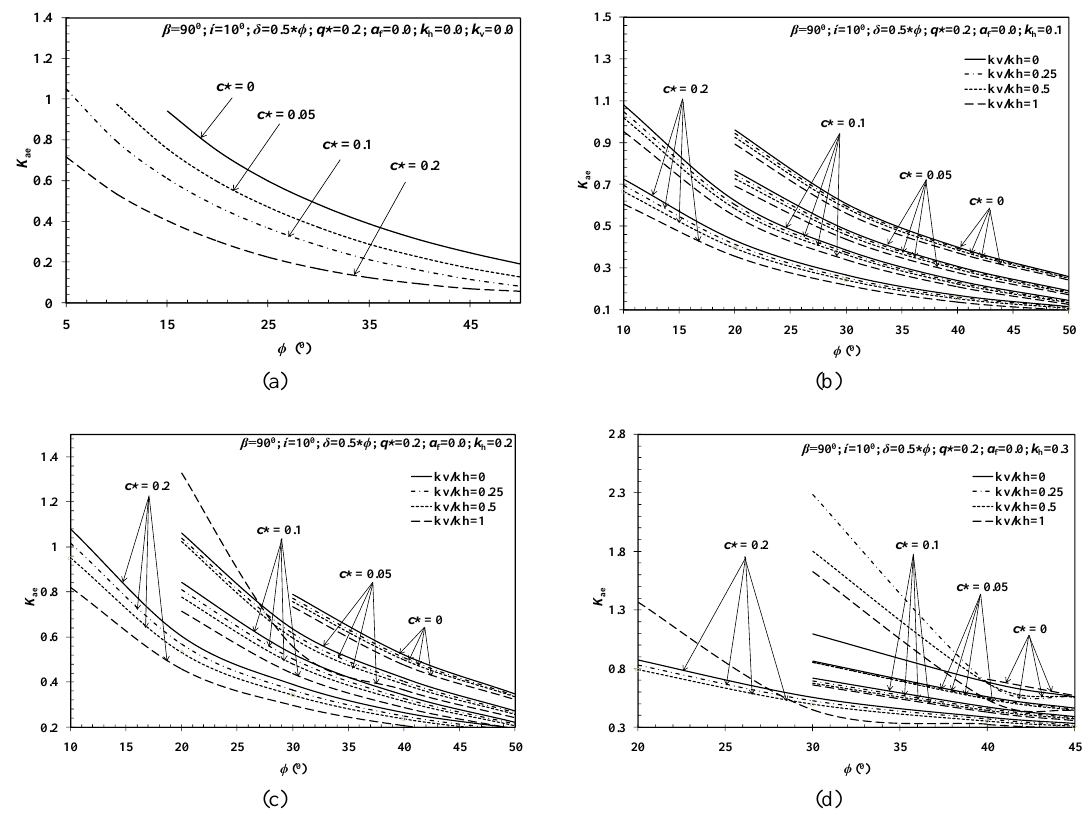
Figure 5. Design charts for K ae for backfill slope i = 10 o and wall inclination β = 90